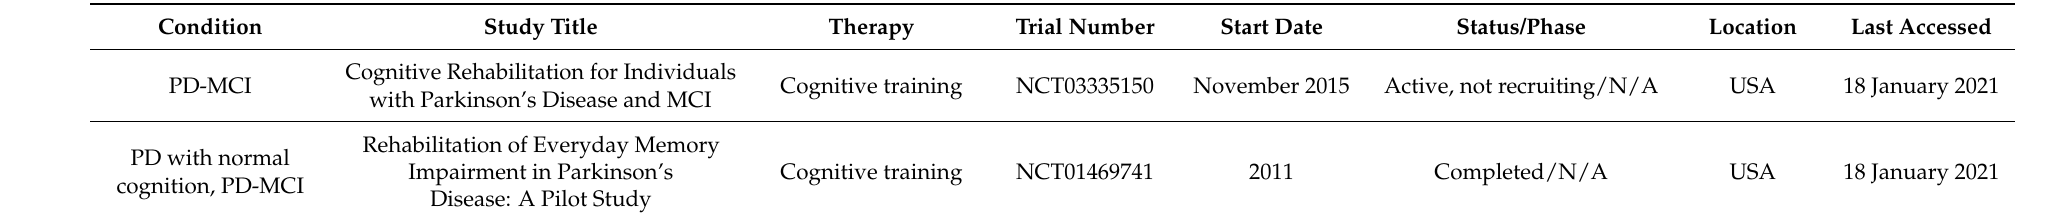
Table 5. Clinical trials on non-pharmacologic treatments for cognitive impairment in Parkinson’s